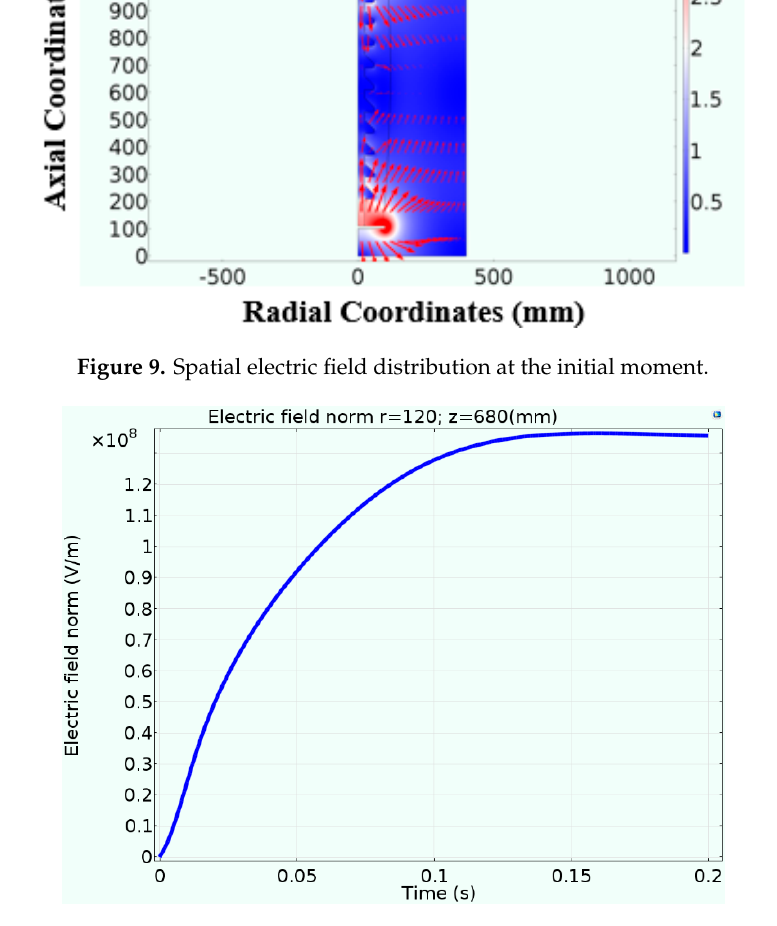
Figure 10. Electric field intensity over time at the midpoint of the discharge area.